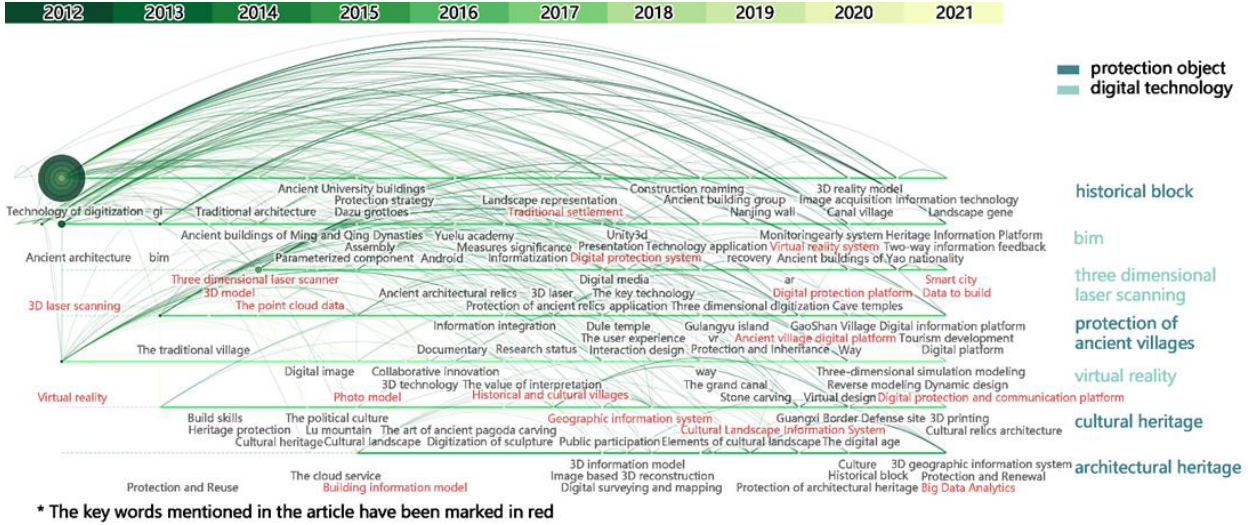
Figure 5. Landscape architecture heritage protection digital technology keywords cluster sequence diagram.